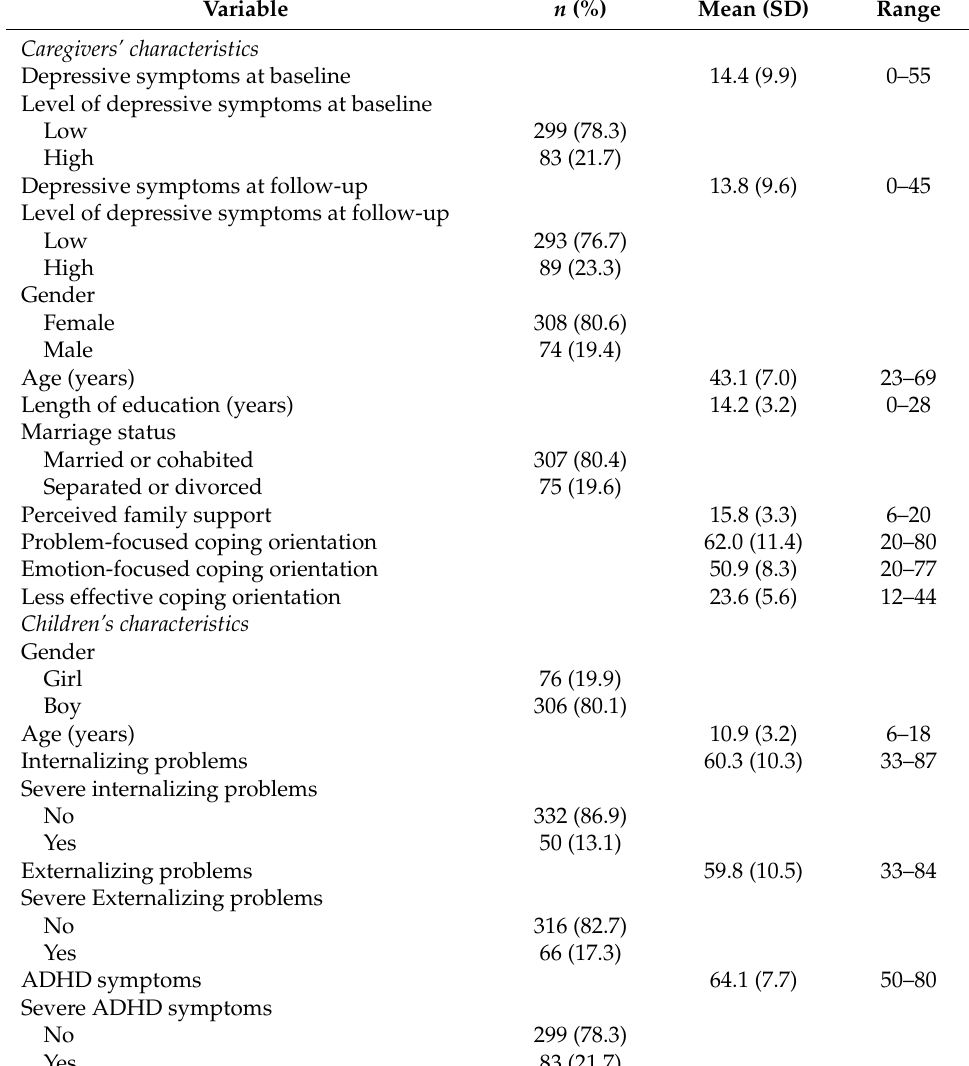
Table 1. Caregivers’ demographics, depressive symptoms, perceived family support, stress-coping orientation and children’s demographics, behavioral, and ADHD symptoms ( n =